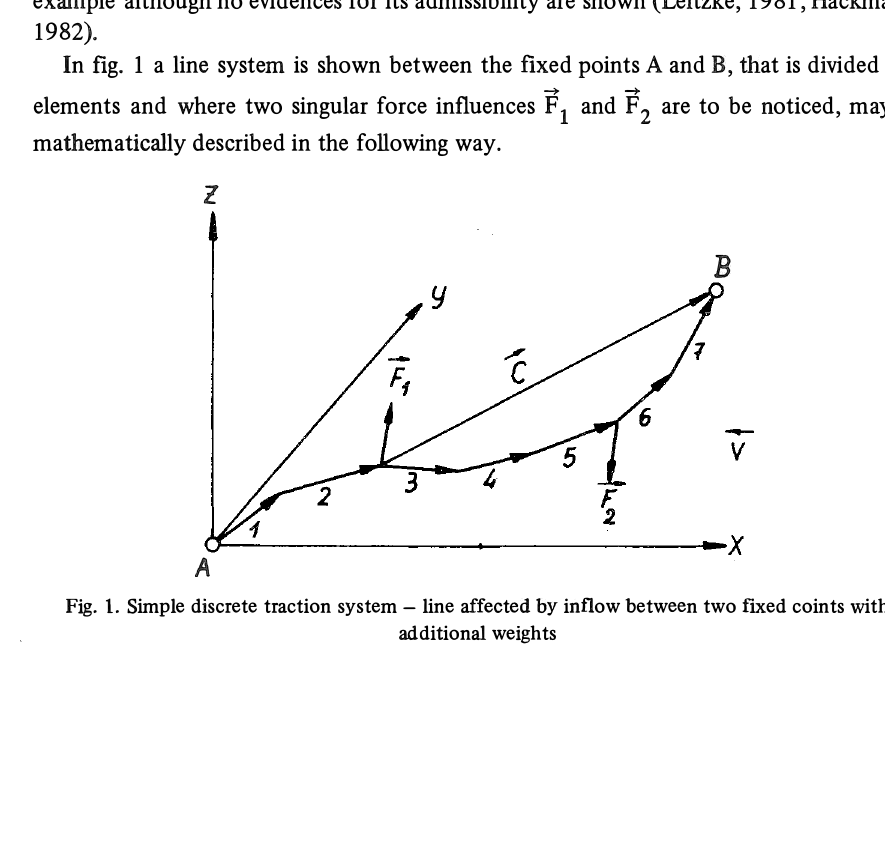
Fig. 1. Simple discrete traction system -line affected by inflow between two fixed coints with additional